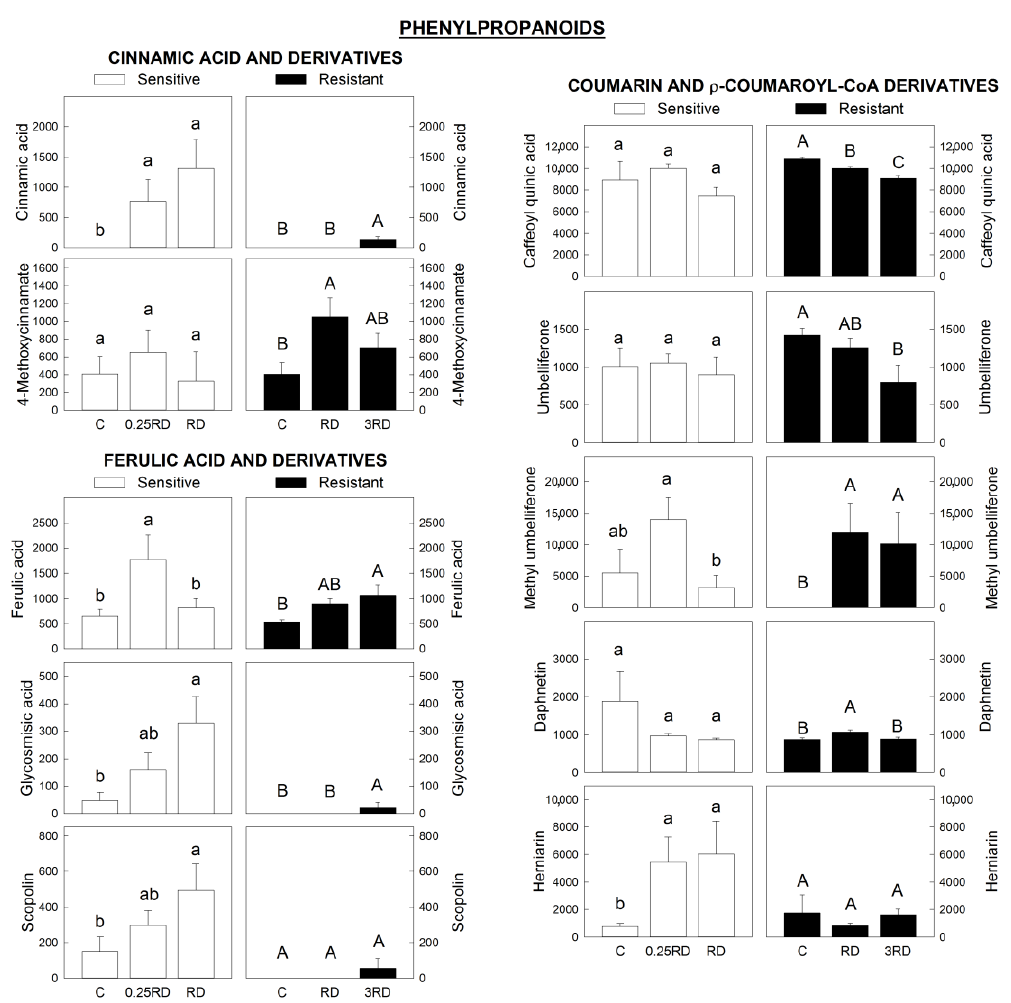
Figure 7. Some phenylpropanoids annotated by LC–MS in glyphosate-sensitive (GS) and-resistant (GR) Amaranthus palmeri plants. Y-axis: peak intensity: phenylpropanoids included are cinnamic acid and derivatives, ferulic acid and derivatives and derivative forms of coumarin and p-coumaroyl-CoA. Plants were not treated (control, C) or treated with glyphosate at two doses. The GS population was treated with 0.25 or 1 the field recommended dose (RD); the GR population was treated with 1 and 3 RD; mean ± SE (n = 6). Different letters within each population indicate significant differences between treatments ( p -value ≤ 0.05, Tukey).